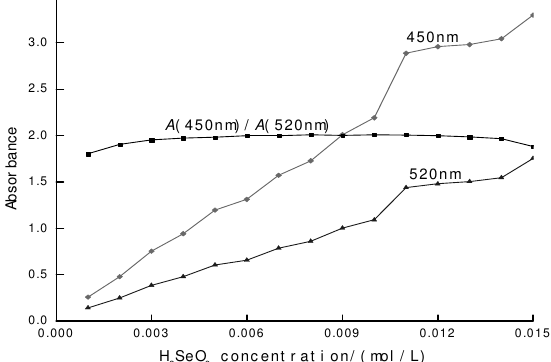
Figure 6. Plots of H